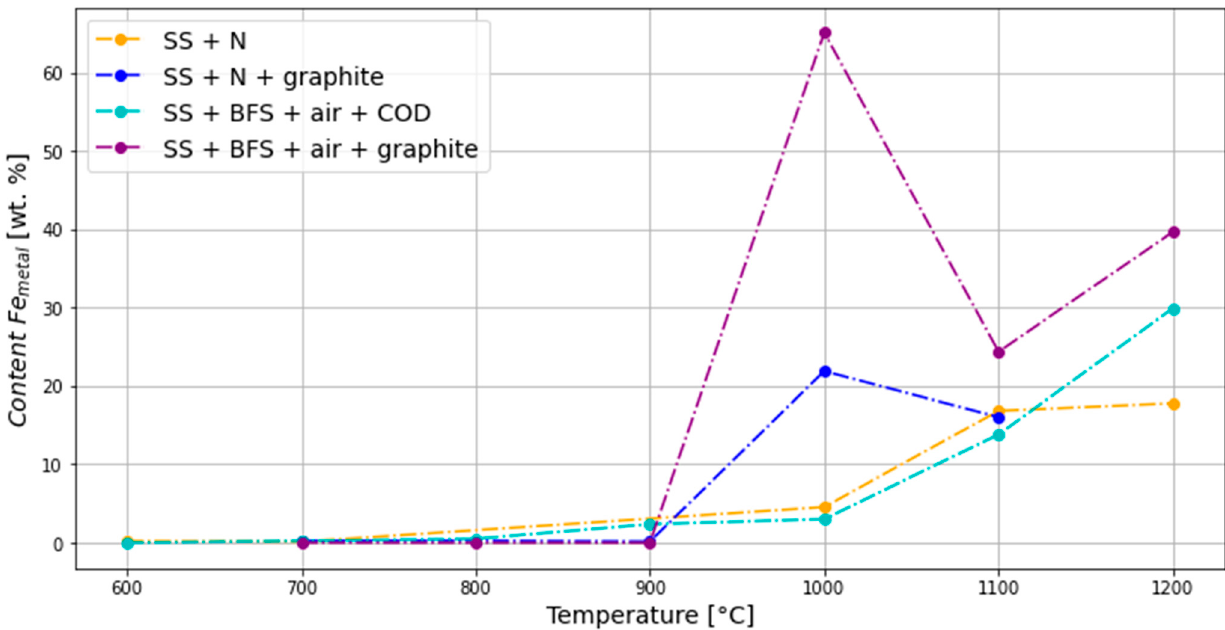
Figure 5. Effect of temperature, atmosphere and reducing element on metallic Fe content in